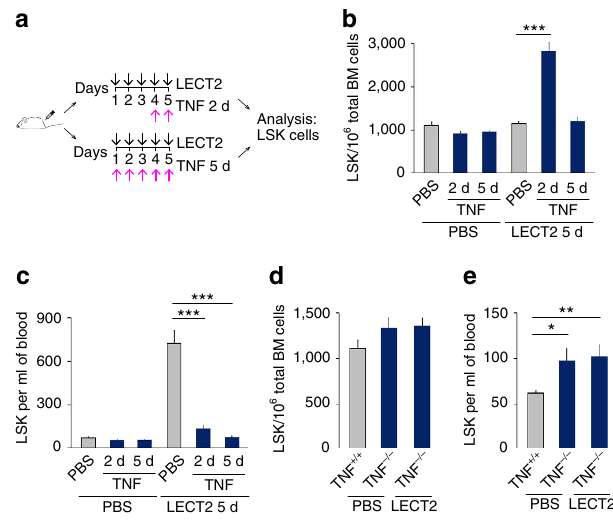
Figure 6 | TNF mediates the effect of LECT2 on HSC expansion and mobilization. ( a ) The protocol for TNF and LECT2 treatment. ( b ) The number of LSK cells in the BM of mice treated with LECT2 combined with TNF. ( c ) The number of LSK cells in the blood of mice treated with LECT2 combined with TNF. n ¼ 5. ( d , e ) LSK cells in the BM and blood of TNF KO mice after LECT2 treatment; n ¼ 6. The data represent means ± s.e.m. The data are representative of two ( b , c ) and three ( d , e )